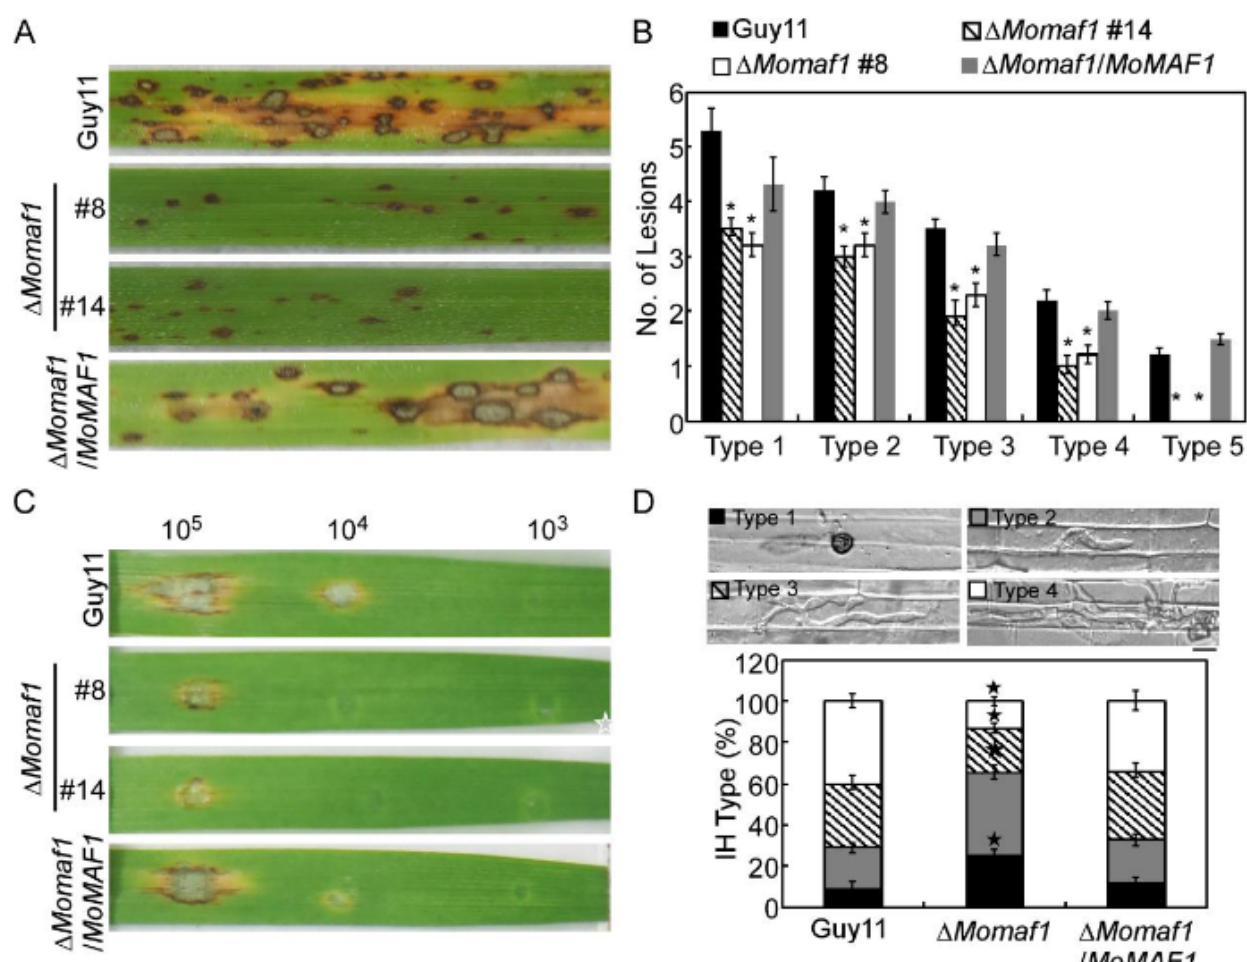
Figure 4. MoMaf1 is required for the virulence of M. oryzae : ( A ) Two-week-old rice seedlings ( Oryza sativa cv. CO-39) were sprayed with 4 mL of a conidial suspension (5 × 10 4 conidia/mL). The diseased leaves were harvested and photographed at 7 days post-inoculation (dpi). Three independent experiments were performed. ( B ) Quantification of lesions of different types (per 1.5 cm 2 ) on diseased rice leaves. Type 1, dark brown pinpoint lesions; type 2, 1.5 mm brown spots; type 3, 2–3 mm lesions with brown margins; type 4, eyespot lesions longer than 3 mm; type 5, coalesced lesions that infected 50% or more of the maximum leaf size (Qian et al., 2021). Error bars represent ± SD, and asterisks denote significant differences ( p < 0.01). ( C ) Detached barley leaves were drop-inoculated with serial dilutions (1 × 10 5 , 1 × 10 4 , 1 × 10 3 spores/mL) of conidial suspensions, and the diseased leaves were photographed at 5 dpi. ( D ) Conidial suspensions (1 × 10 5 spores/mL) were injected into rice sheaths, and infection severity was observed at 36 hpi. The percentages of different types of infectious hyphae (IH) in the rice cells were quantified at 30 hpi. Error bars represent the SD, and asterisks denote the significant differences of each type ( p < 0.01). Type 1, no penetration; type 2, only a single invasive hypha (IH) without branches; type 3, 1–3 branches but restricted to one cell; type 4, more than three branches and extended to the neighboring cell. Fifty infected cells were observed for each strain and the experiment was repeated 3